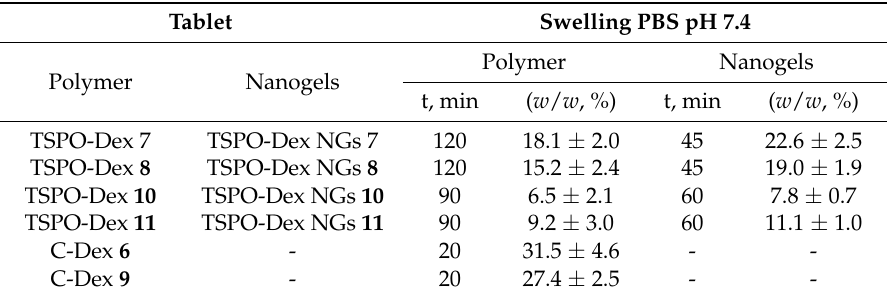
Table 4. Swelling degree of C-Dex, TSPO-Dex conjugates and TSPO-Dex NGs after 2 h. Tablet Swelling PBS pH 7.4